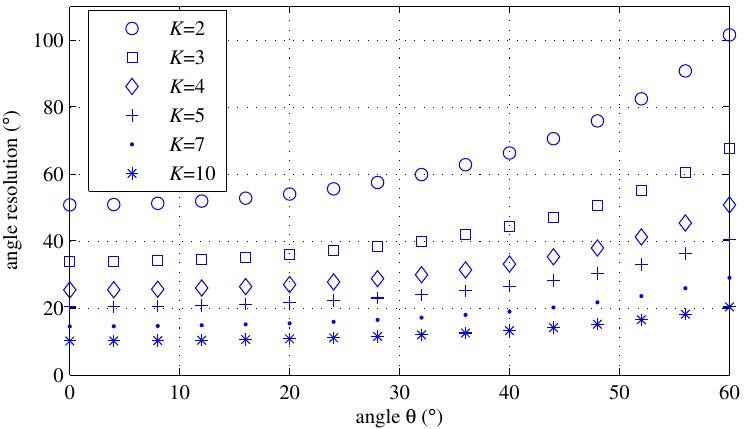
Figure 7. Angle resolution ∆ θ according to angle for several K values.